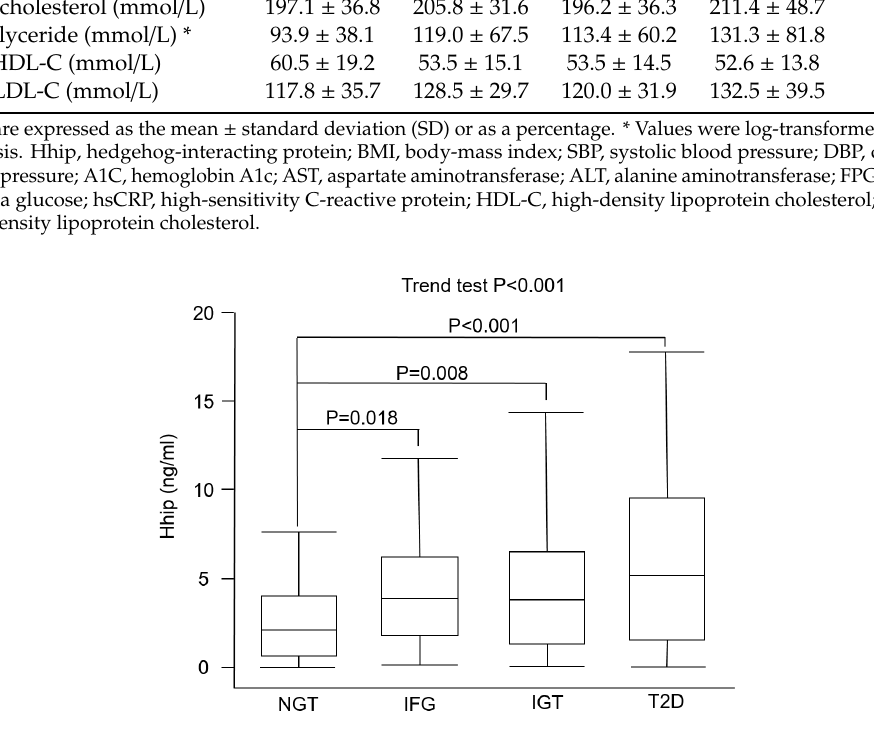
Figure 1. Plasma concentrations of the hedgehog-interacting protein (Hhip) in subjects with prediabetes or diabetes. Box and whisker plot of plasma Hhip concentrations in participants with normal glucose tolerance (NGT; n = 75), impaired fasting glucose (IFG; n = 66), impaired glucose tolerance (IGT; n = 86), and type 2 diabetes (T2D; n = 87). The line inside the box represents the median of the distribution, the box top and bottom values are defined by the 25th and 75th percentiles, and the whiskers are minimum and maximum values.